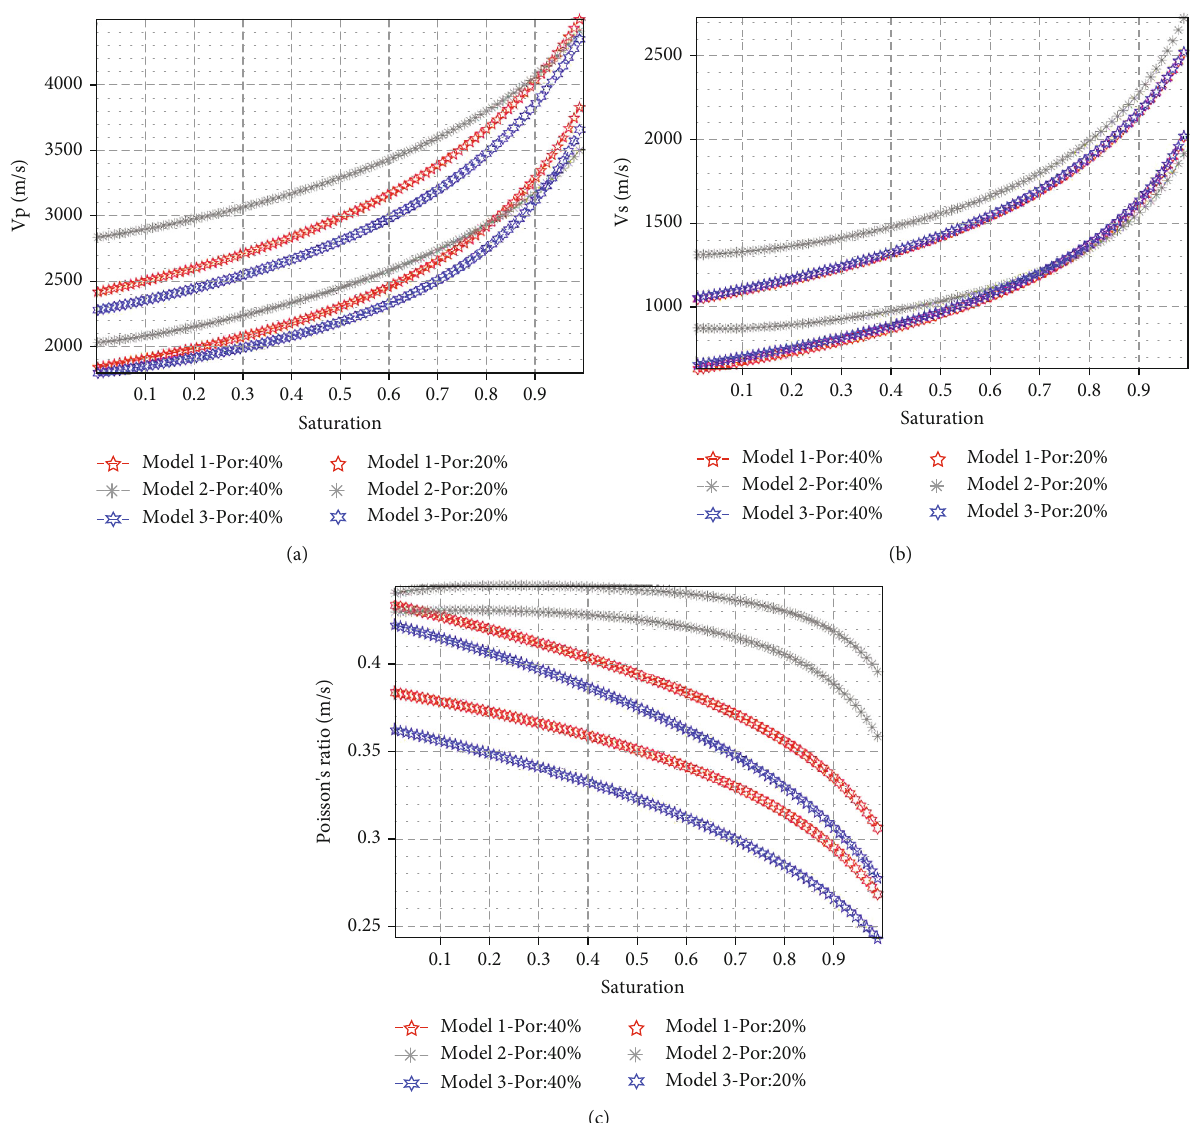
Figure 8: Relationship of V , V , Poisson ’ s ratio, and hydrate saturation of saturated rock in a hydrate reservoir. Model 1 is a pore- fi lling p s model, Model 2 is a thermodynamic elastic model, and Model 3 is a particle cementation model; P40 and P20 represent porosities of 40% and 20%, respectively. (a) Relationship of V and hydrate saturation of saturated rock in a hydrate reservoir; (b) relationship of V p hydrate saturation of saturated rock in a hydrate reservoir; (c) relationship of Poisson ’ s ratio and hydrate saturation of saturated rock in a hydrate